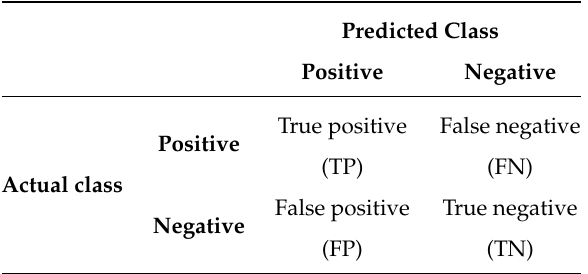
Table 1. Binary confusion matrix.